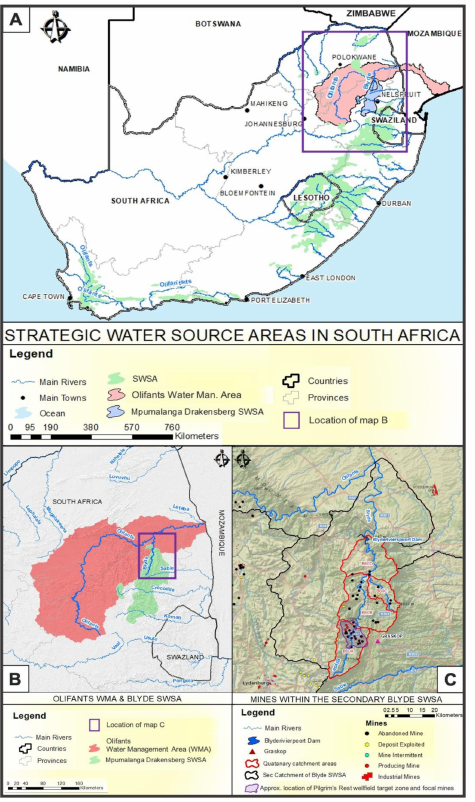
Figure 1. ( A ) Map of South Africa, with all strategic water (source) areas (SWSA); ( B ) the Olifants Water Management Area (WMA) in relation to the Mpumulanga Drakensberg SWSA; and ( C ) detail of the mines in the secondary Blyde